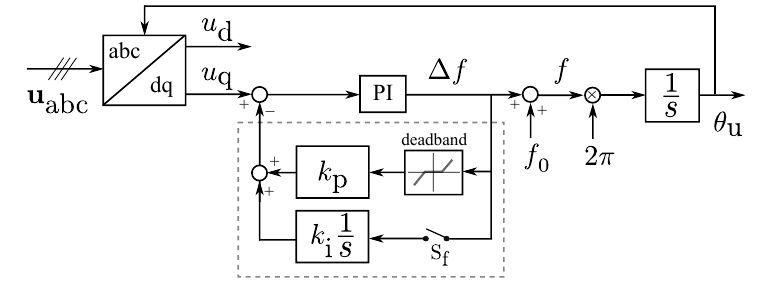
Figure 3. Proposed PLL model used in